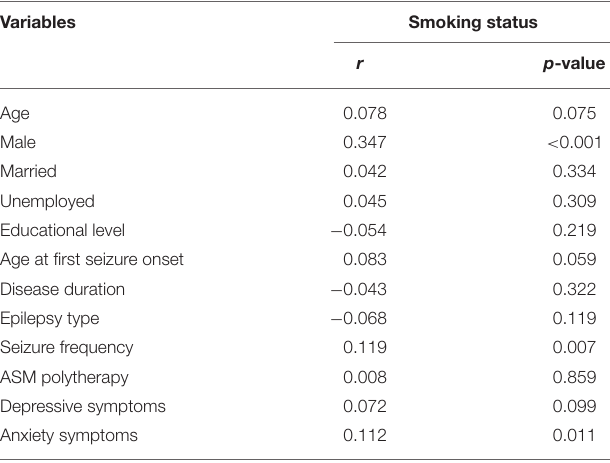
TABLE 3 | Correlation between smoking status and other variables among